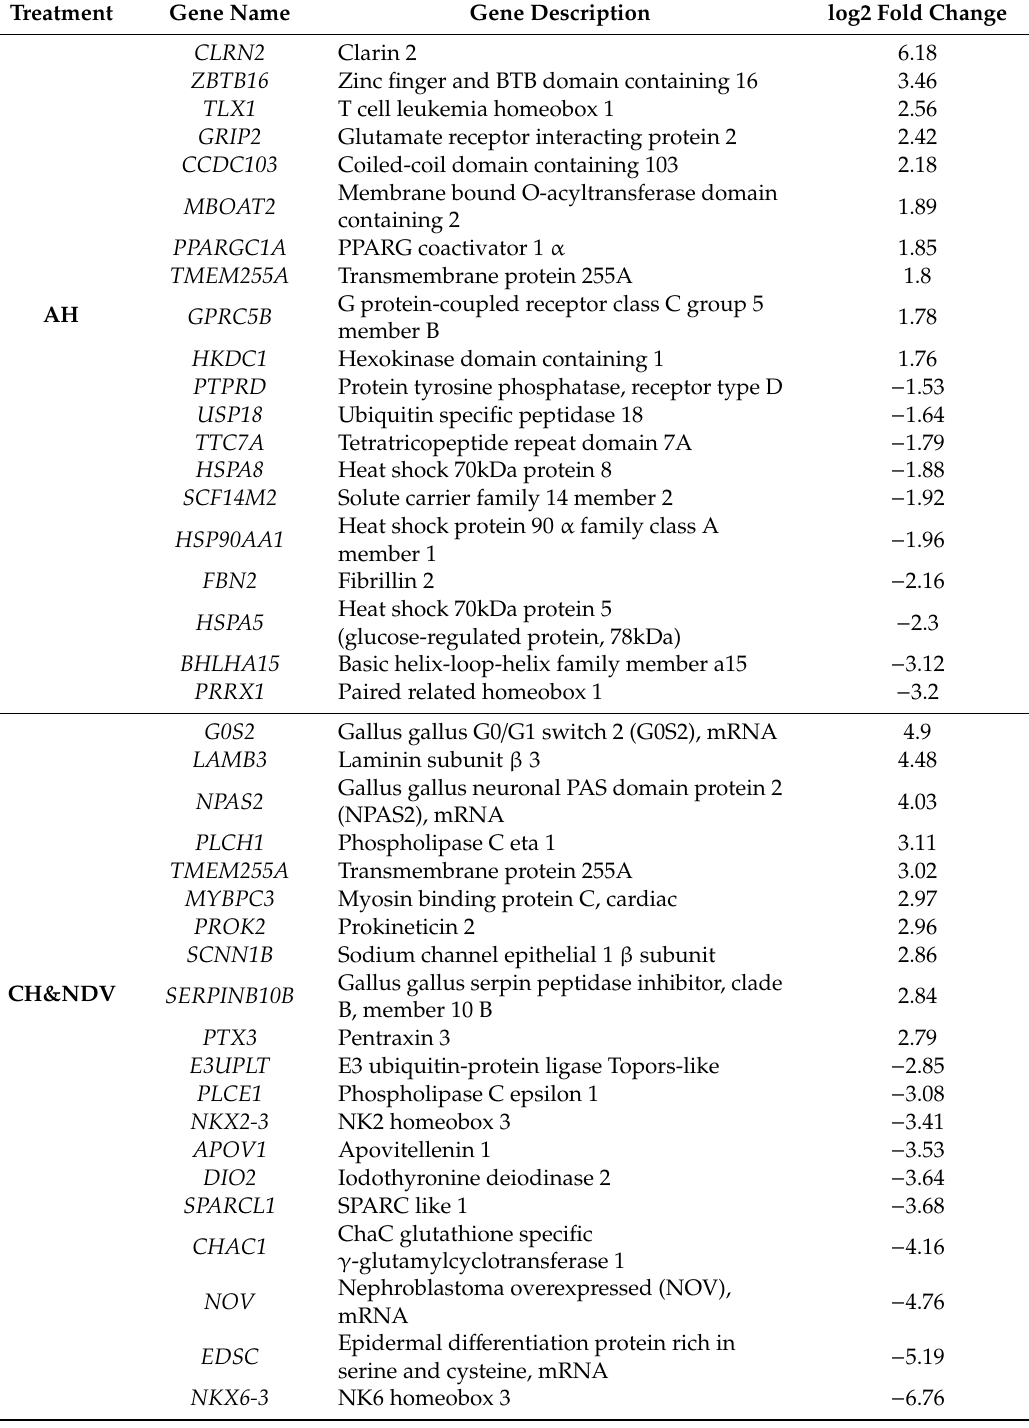
Table 9. Top 10 up- and down-regulated DEGs in the Fayoumi